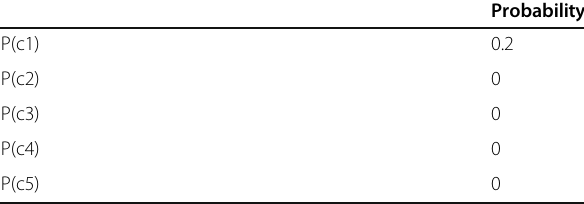
Table 2 The calculation of second point